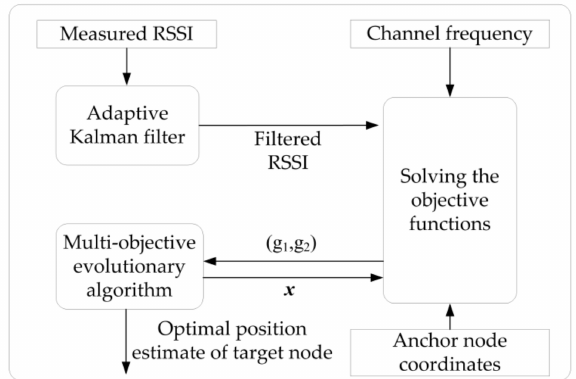
Figure 1. The structure of the optimal multi-channel trilateration positioning algorithm (OMCT) using the received signal strength indication